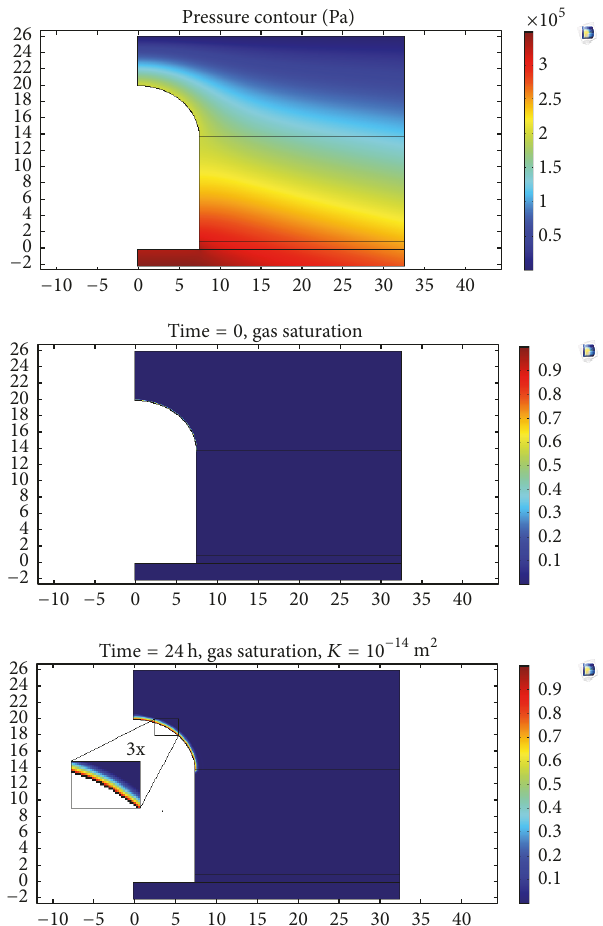
Figure 5: Pressure and gas saturation contours of the example of gas seepage